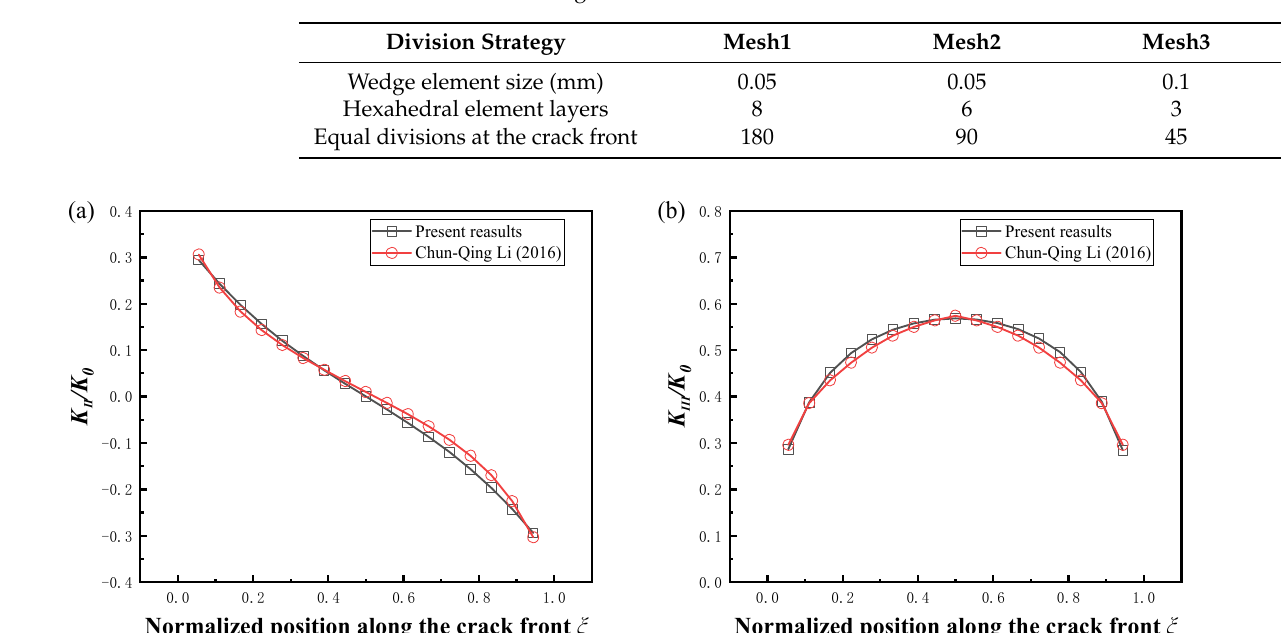
Figure 5. Comparison of the stress intensity factors with mixed modes, a/t = 0.2, a/c = 0.4, θ = 45 ◦ . ( a ) Normalized K II , ( b ) normalized K III [19] .